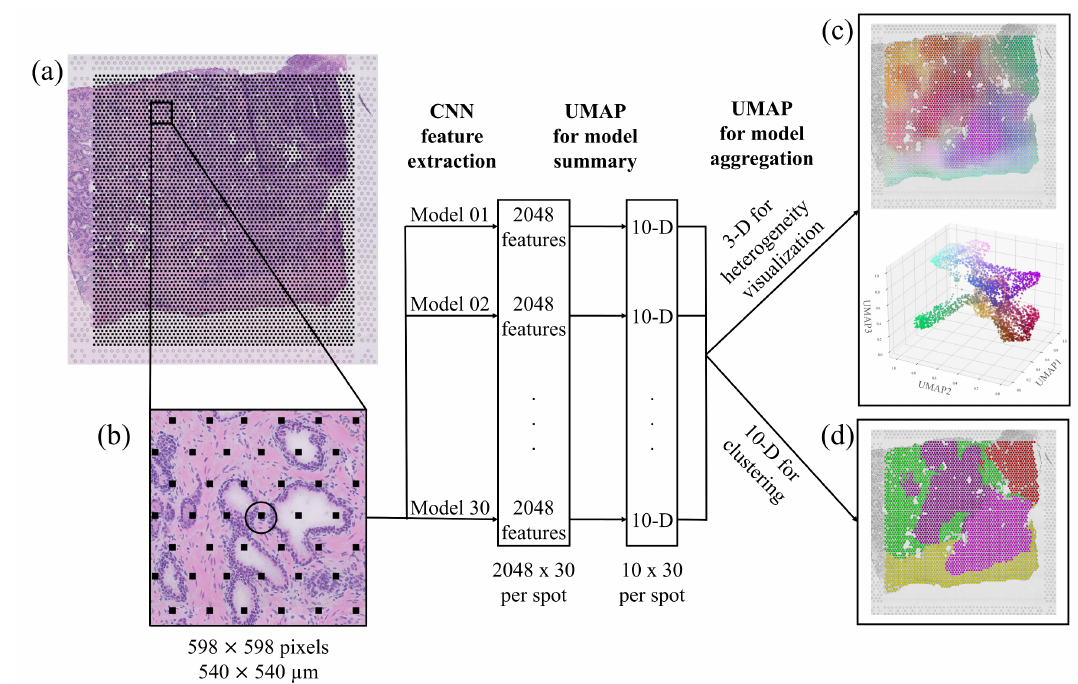
Figure 2. Workflow for deep morphological feature extraction. ( a ) Original section on the whole-slide image. ( b ) A patch of 598 × 598 pixels extracted centered around an ST spot and fed to the network. The network consists of 30 models, each extracting 2048 features, which are independently reduced to 10 dimensions. Dimensionality reduction is applied again to aggregate the model into ( c ) 3 dimensions where the morphological descriptors are mapped to the original tissue position and presented in a 3D RGB color space, visualizing tissue heterogeneity, and into ( d ) 10 dimensions to cluster tissue